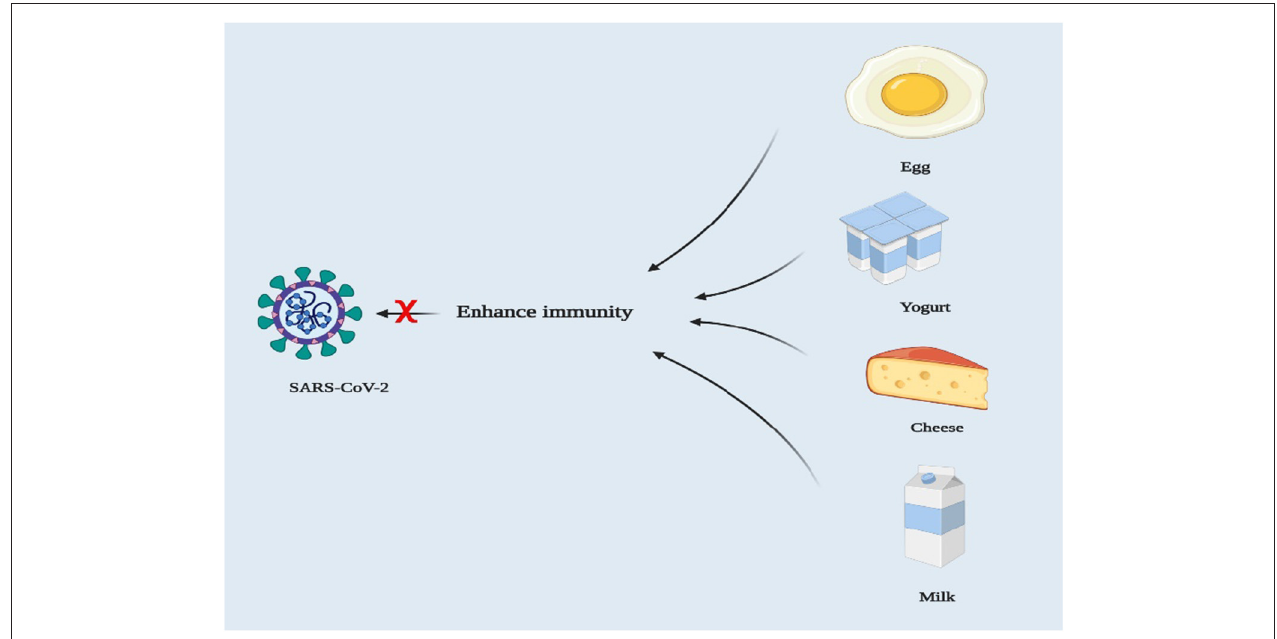
FIGURE 1 | Food sources enhancing the immune response.